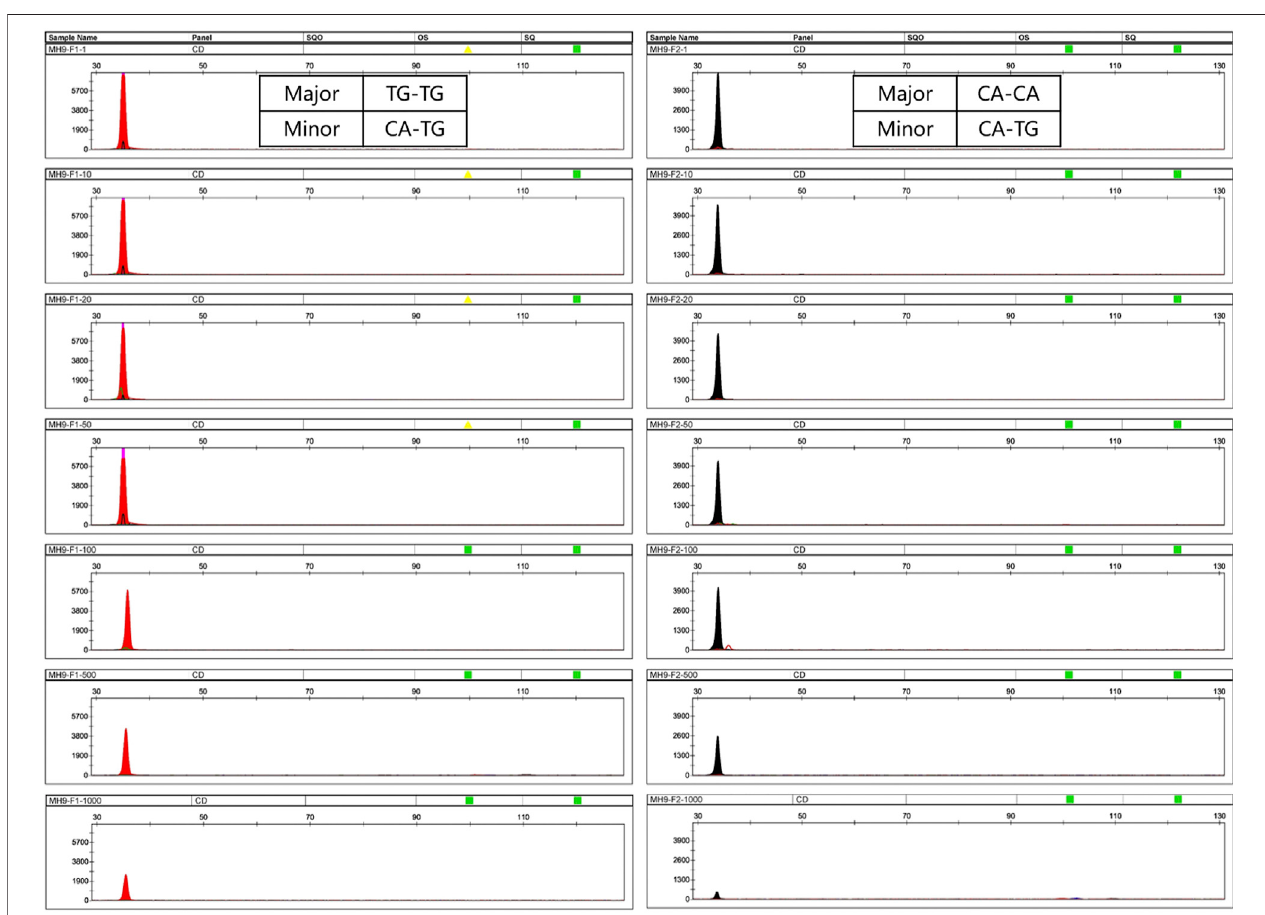
FIGURE 3 | Pro fi les of mixtures using a single SNP-SNP marker. Here, MH9 was selected as an example. (A,B) represent two different mixtures. In mixture A, the minor DNA genotype is CA-TG, the genotype of the major DNA is TG-TG, and the allele-speci fi c primer MH9-F1 was used to target CA of the minor DNA. Similarly, in mixtureB, theminor DNAgenotype isCA-TG, thegenotypeofthemajor DNAisCA-CA, andthe primerMH9-F2wasusedtotargettheTGoftheminor DNA. Theminor DNA was fi xedat 0.05ng,themixingratiowas1:1 – 1:1,000, andthetemplateDNA amountwas1 μ L.Atthislocus,thetwoallele-speci fi cprimerscansuccessfully amplify minor DNA at a ratio of up to